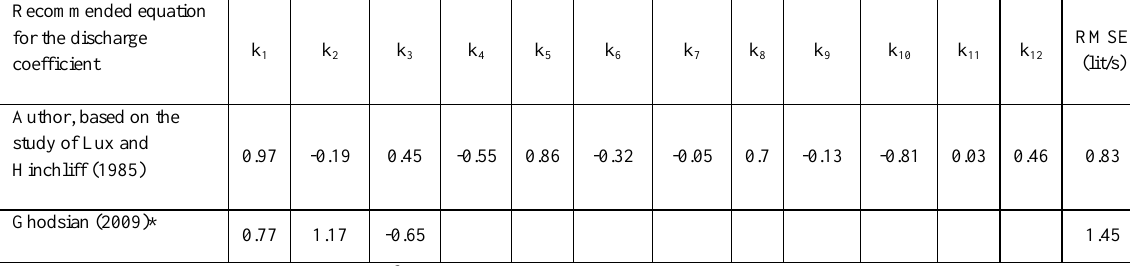
Table 2. Optimized coefficients and the RMSE values for the proposed equation model and that